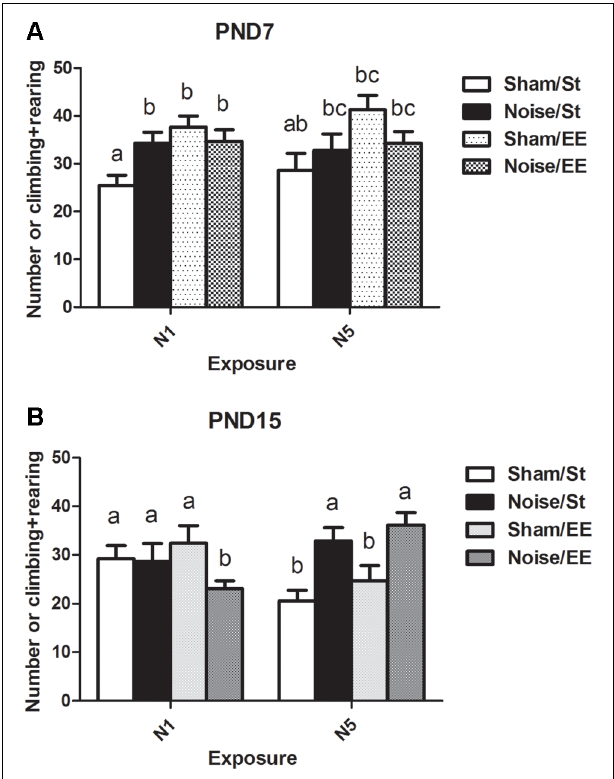
FIGURE 5 | Number of elevations (climbing and rearing) made by PND28 animals exposed to noise at PND7 and PND15 in the OF task. (A) PND28 animals exposed at PND7; (B) PND28 animals exposed at PND15. Sham: non- exposed animals; N1: single noise exposure; N5: five-daily noise exposure. St: standard housing. EE: enriched environment. Different letters (a, b, c) symbolize significant differences with p < 0.05. Data represent the mean ± SEM of the number of elevations (climbing and rearing) made in the OF task, n = 7 for each